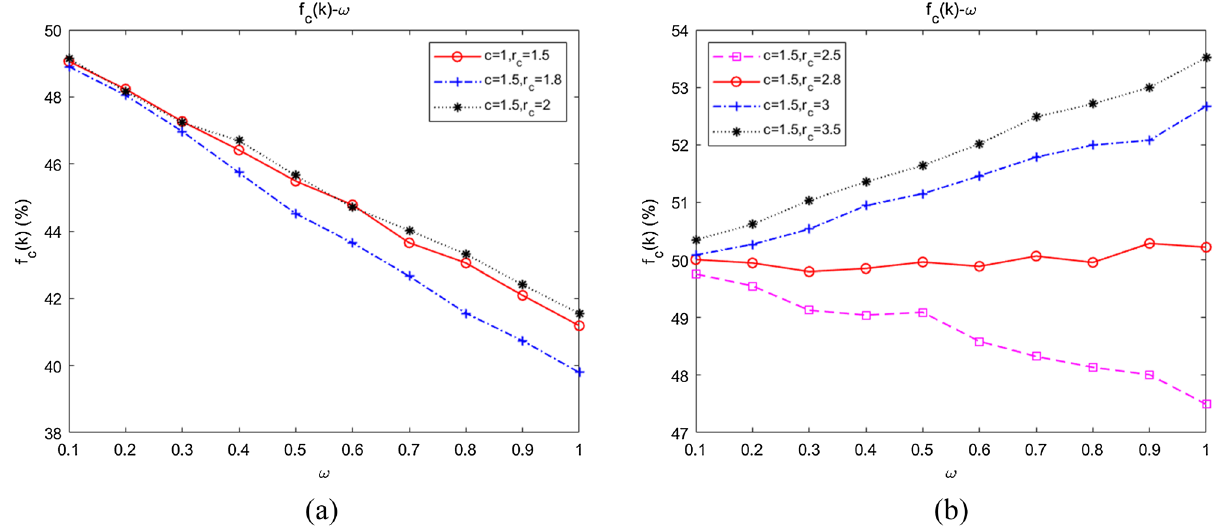
Figure 14. ( a ) Effects of cost and the multiplication factor on average abundance when the defection strategy dominates; ( b ) effects of cost and the multiplication factor on average abundance when the collaboration strategy